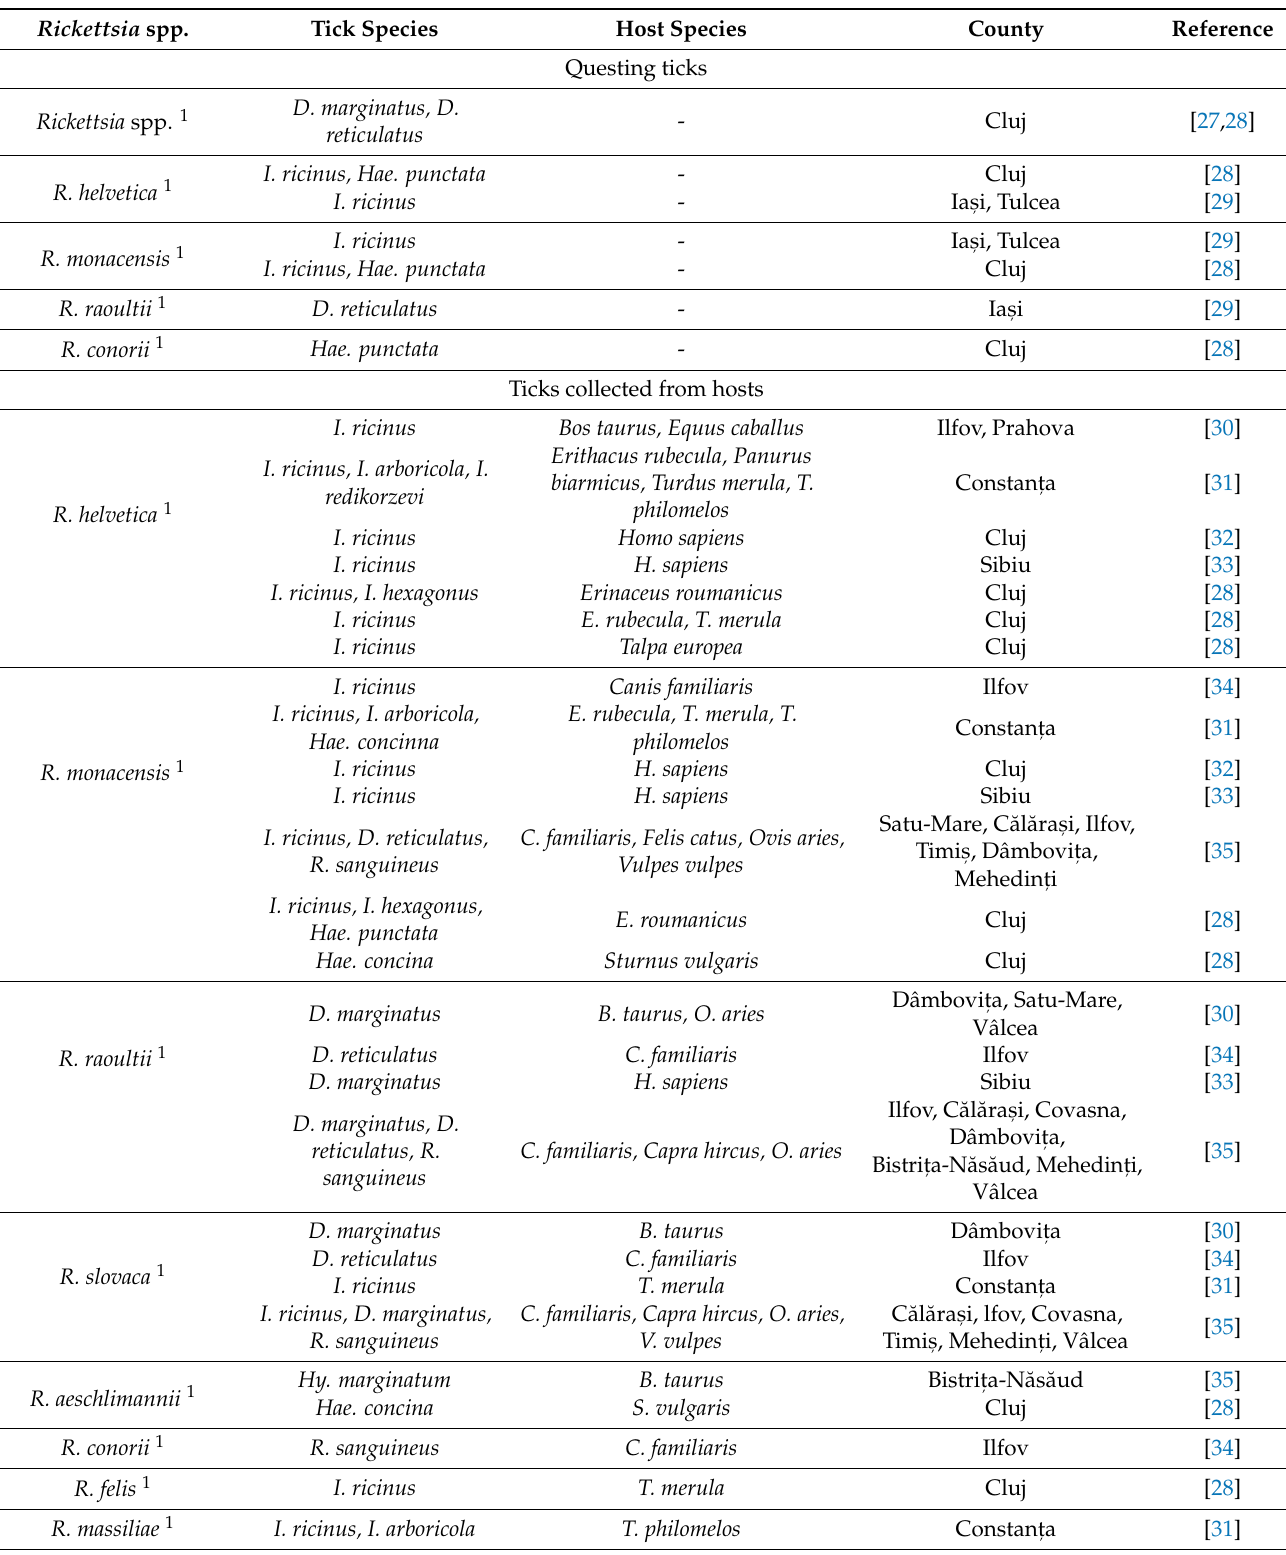
Table 1. Overview of Rickettsia species in questing and engorged ticks, as well as vertebrate host tissues, in